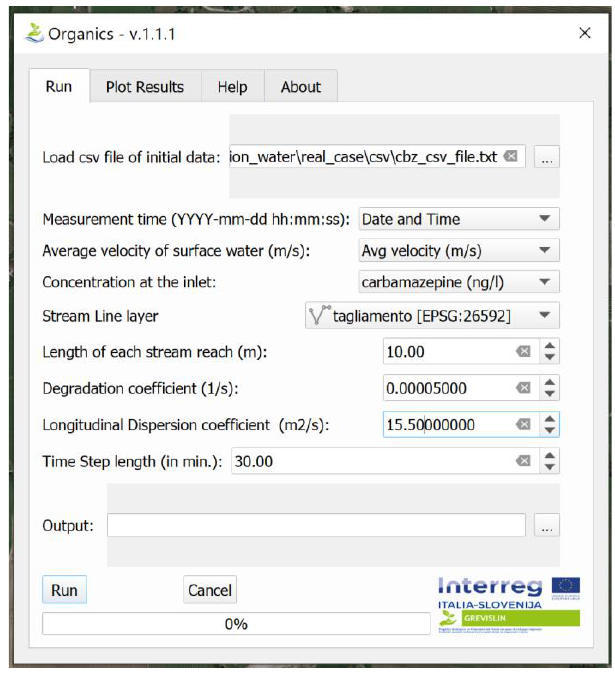
Figure 2. The ORGANICS plugin main window.